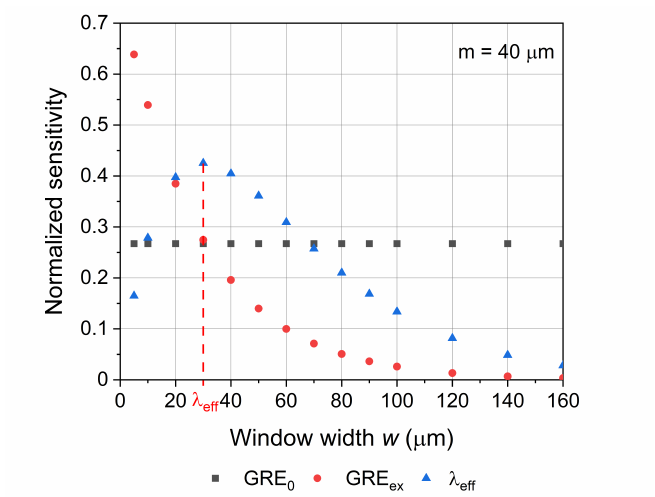
Figure 9. Normalized sensitivity of GRE to GRE 0 , GRE ex and λ ef f as a function of window width, for a constant mask width m = 40 µ m (at the window